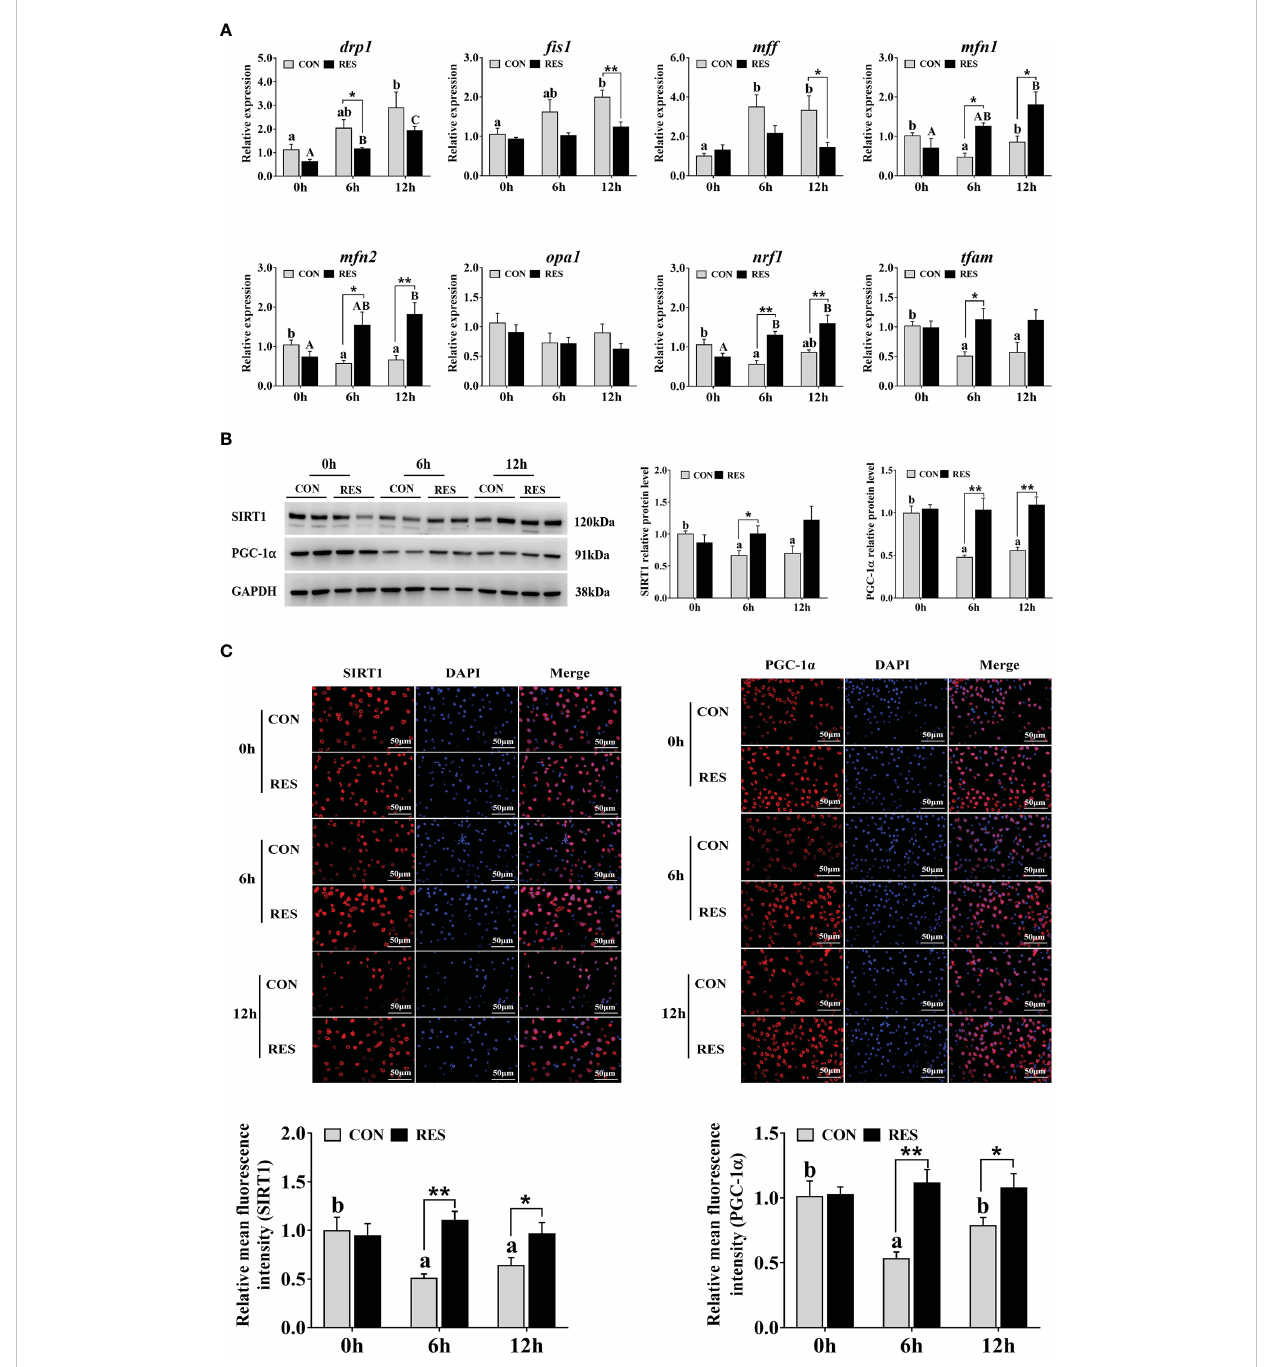
FIGURE 7 Effect of dietary RES on mitochondrial dynamics and mitochondrial biogenesis in the liver of gibel carp at 6 h and 12 h after LPS injection. (A) Mitochondrial dynamics related mRNA levels were determined by qRT-PCR. (B) Western blots for SIRT1 and PGC-1 a and quanti fi cation results. (C) Immuno fl uorescent analysis of SIRT1 and PGC-1 a stained with antibody (red) or DAPI (blue) and relative fl uorescence intensity. Bars = 50 µm. Data are mean ± SEM (n = 6). The lowercase letters represent signi fi cant differences among diverse LPS durations in the CON group ( P < 0.05); the uppercase letters represent signi fi cant differences among diverse LPS durations in the RES group ( P < 0.05). *( P < 0.05) and **( P < 0.01) represent signi fi cant differences between the CON and RES groups. Drp1 , dynamin-related protein 1; fi s1 , mitochondrial fi ssion 1; mff , mitochondrial fi ssion factor; mfn1 , mitofusin 1; mfn2 , mitofusin 2; opa1 , optic atrophy 1; nrf1 , nuclear respiratory factor 1; tfam , mitochondrial transcription factor